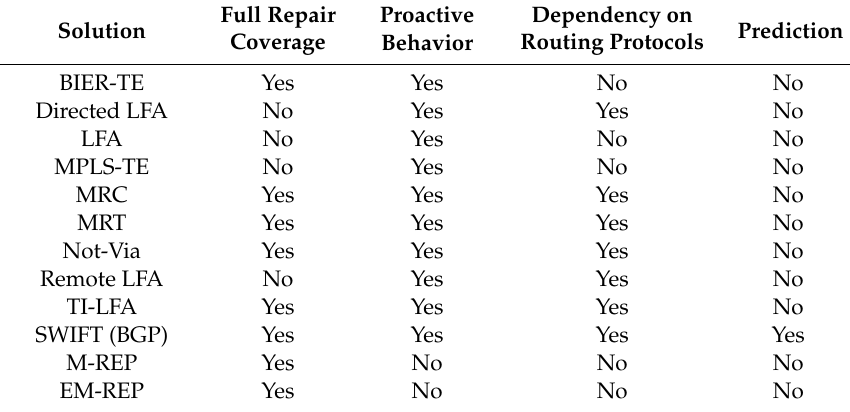
Table 1. Comparison of FRR